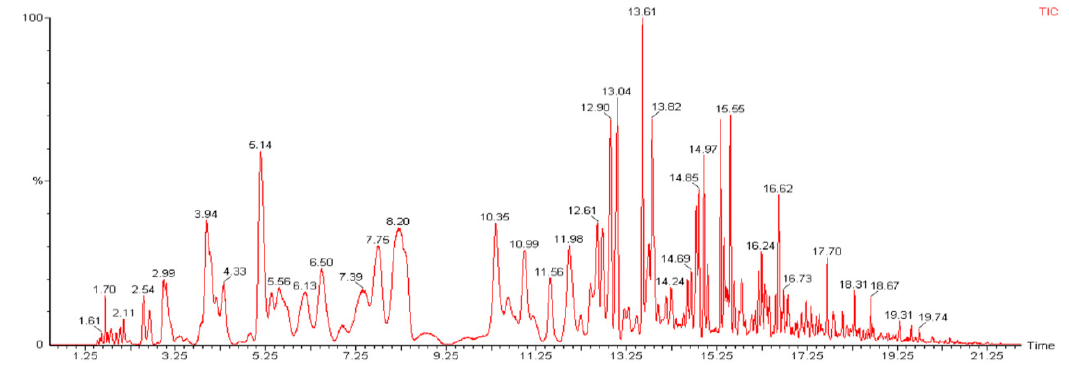
Figure 1. Chromatogram of a sample of diesel oil no. 16, recorded in TIC mode.